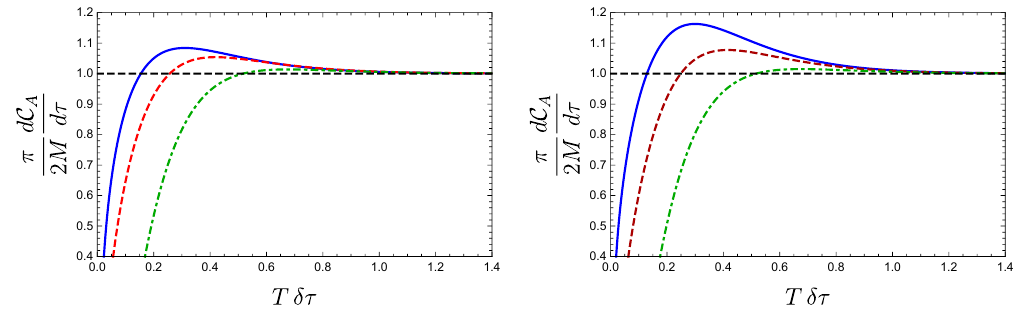
Figure 20 . Time derivative of complexity as a function of time for spherical (left) and planar (right) geometries in d = 3 boundary dimensions for various values of the horizon radius | r h = L (solid blue), r h = 1 : 5 L (dashed red), r h = 3 : 5 L (dot-dashed green). We present the plot as a function of the time coordinate in units of the thermal scale (cid:14)(cid:28) T = ( (cid:28) (cid:0) (cid:28) c ) T . We stress again that the complexity starts changing at (cid:28) c and each of the curves presented has a di(cid:11)erent value of (cid:28) c . For these parameters, the violation of the late time bound is clearly